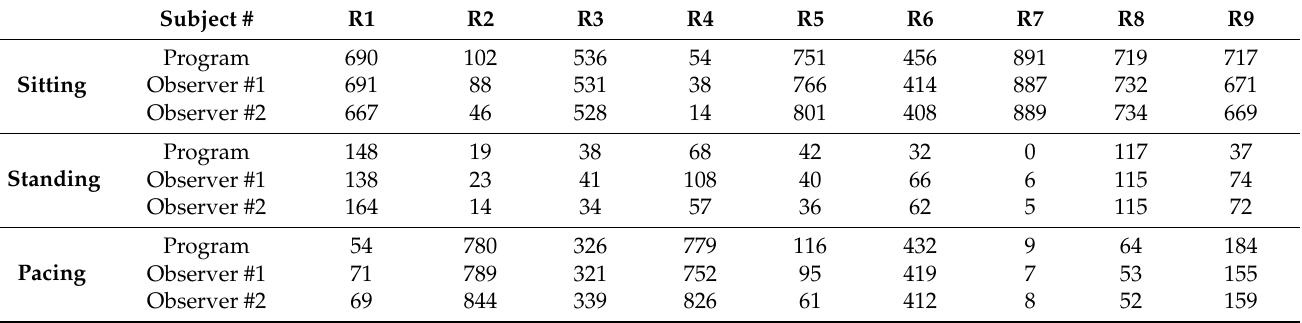
Table 4. Comparison of raw data between measurement analysis from the automated program and two observers for each